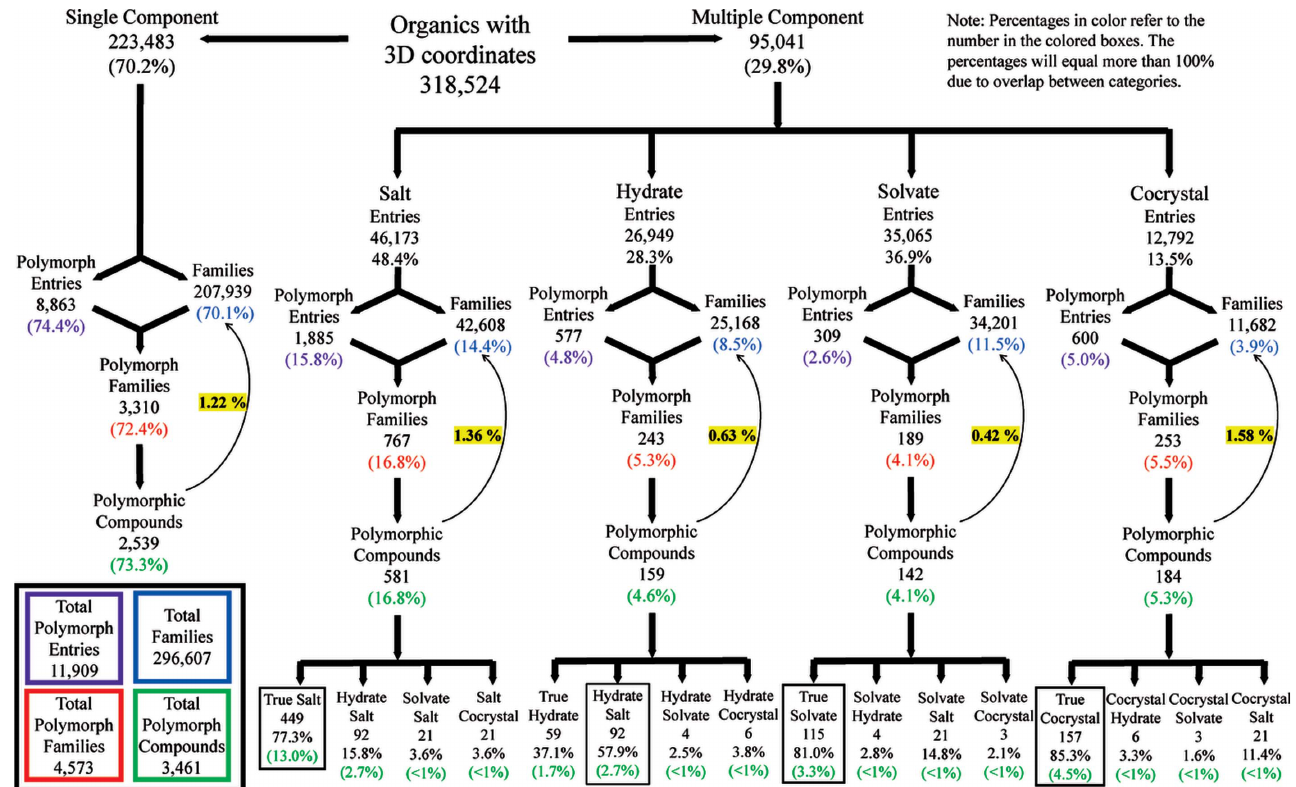
Figure 2 A breakdown of each type of organic crystal found in the 2015 version of the CSD (November 2015, Version 5.37 with one update). Entries are determined from a search for that particular crystal type. Families are calculated based on the number of distinct refcode families within a particular search. Solvates in this case refer to non-hydrated solvates. True crystals refer to compounds with only the minimal chemical units necessary to produce that crystal type (Grothe et al. , 2016). Polymorphic compounds are those on the list of polymorph families which have two structurally determined forms (see section S6 of the supporting information for more